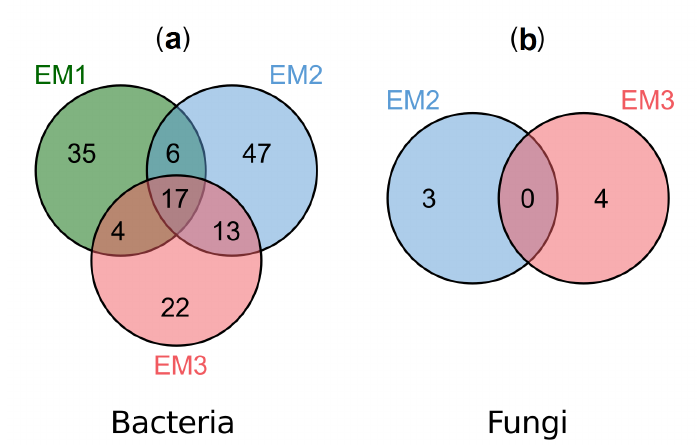
Figure 1. Venn Diagram of ( a ) Bacteria and ( b ) Fungi OTUs. EM2 = Produced in the region of Muriaé; EM3 = Produced in the region of Viçosa. Within the diagram, the number represents the number of OTUs.